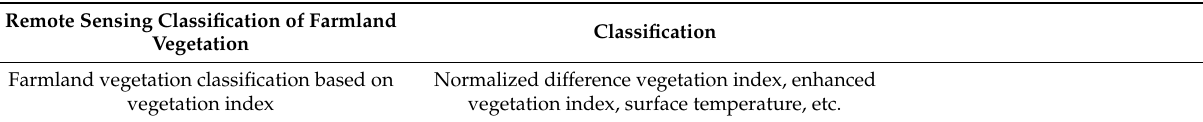
Table 1. Summary of remote sensing classification methods for farmland vegetation. Remote Sensing Classification of Farmland Classification Vegetation Farmland vegetation classification based on Normalized difference vegetation index, enhanced vegetation index vegetation index, surface temperature, etc. Remote sensing recognition of crops based on single image Farmland vegetation classification based on spectral band Remote sensing recognition of crops based on multi-temporal remote sensing images Farmland vegetation classification based on multi-source data fusion